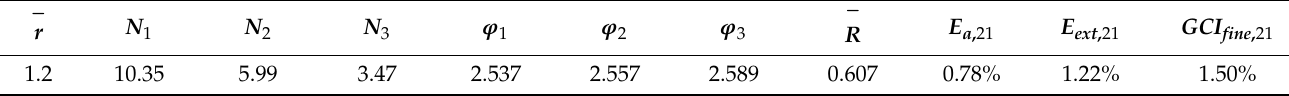
Table 5. Results of the mesh convergence study for the London